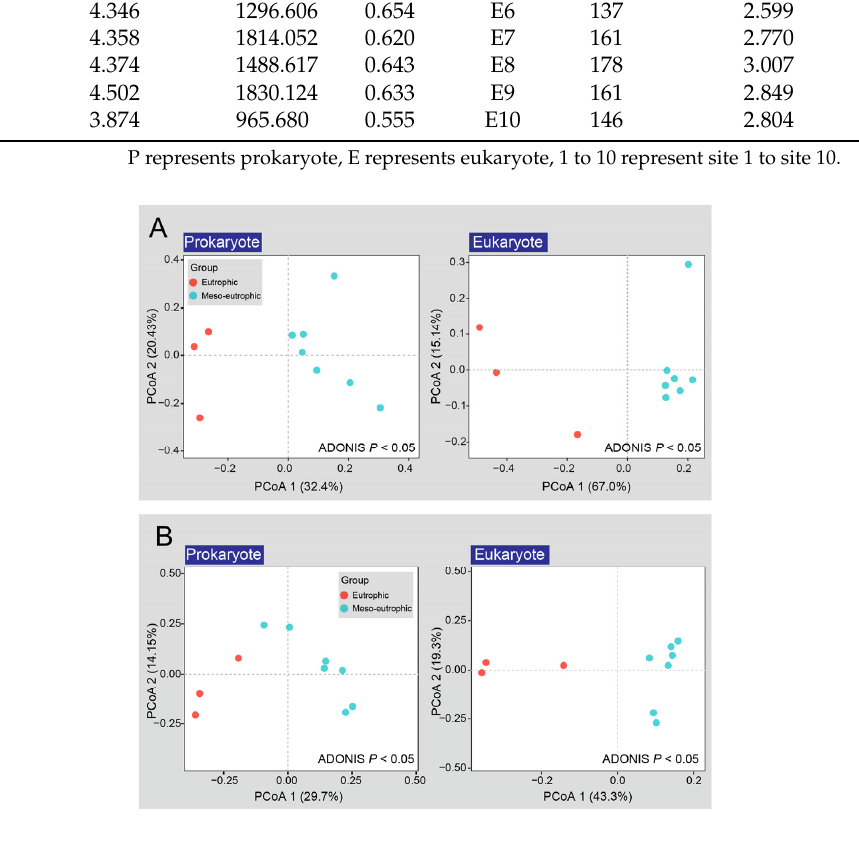
Figure 2. PCoA analysis for samples from eutrophic regions (site 1 to 3) and meso-eutrophic regions (site 4 to 10) based on Bray-Curtis dissimilarity ( A ) and unweighted unifrac dissimilarity ( B ), respec- tively. P represents significance between two regions based on ADONIS analysis for prokaryotes and eukaryotes. P < 0.05 is considered as statistically